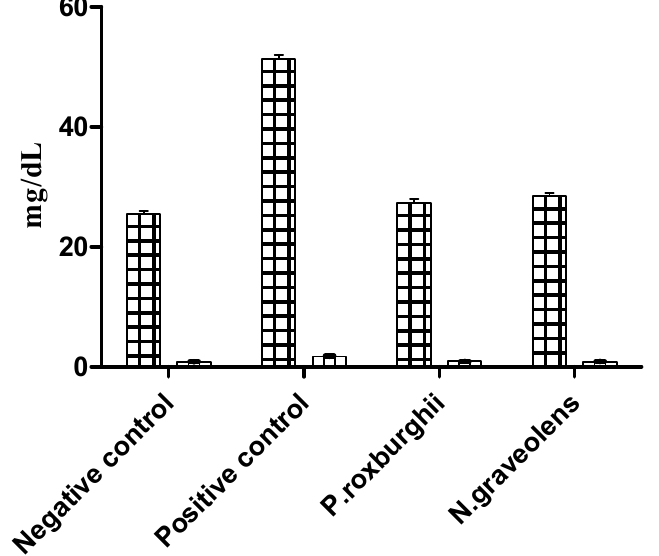
Figure 4. Levels of serum urea and creatinine in different groups.